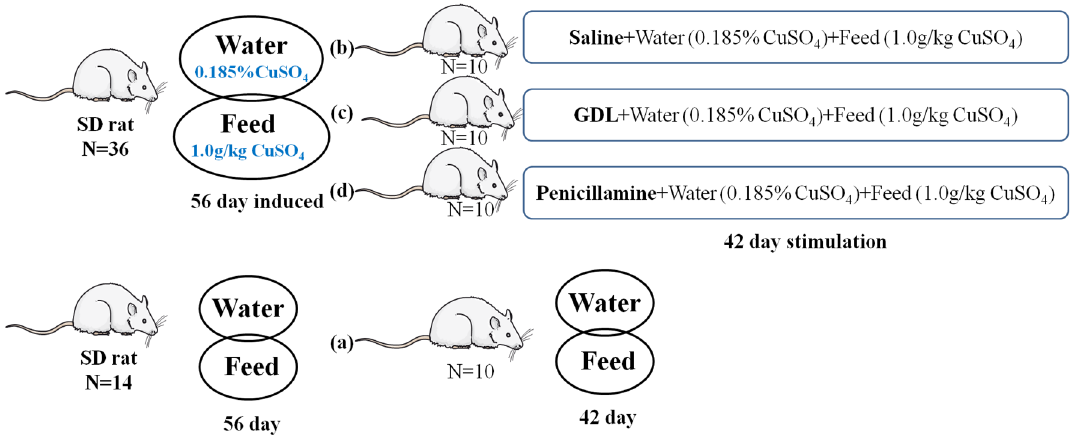
Figure 1. Schematic of the experimental design. The rats were anesthetized and sacrificed by cervical dislocation 24 h after the end of the stimulation period. Plasma was obtained through the centrifugation of blood samples at 3000 rpm for 10 min and was stored at − 80 °C until analysis [19]. Some heart tissues were rinsed in ice-cold phosphate-buffered saline and were stored at − 80 °C for Cu anal- ysis, and the remaining tissues were fixed with 4% paraformaldehyde and 2.5% glutaral- dehyde at 4 °C for histopathological analyses.